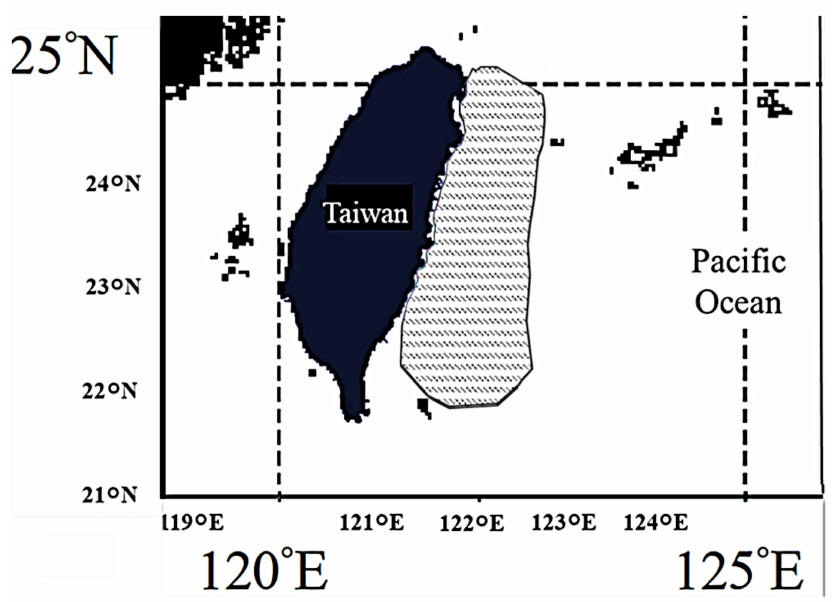
Figure 1. Fishing ground of M. pelagios , in the eastern Taiwan waters (shaded area is the operation area of large-mesh drift net